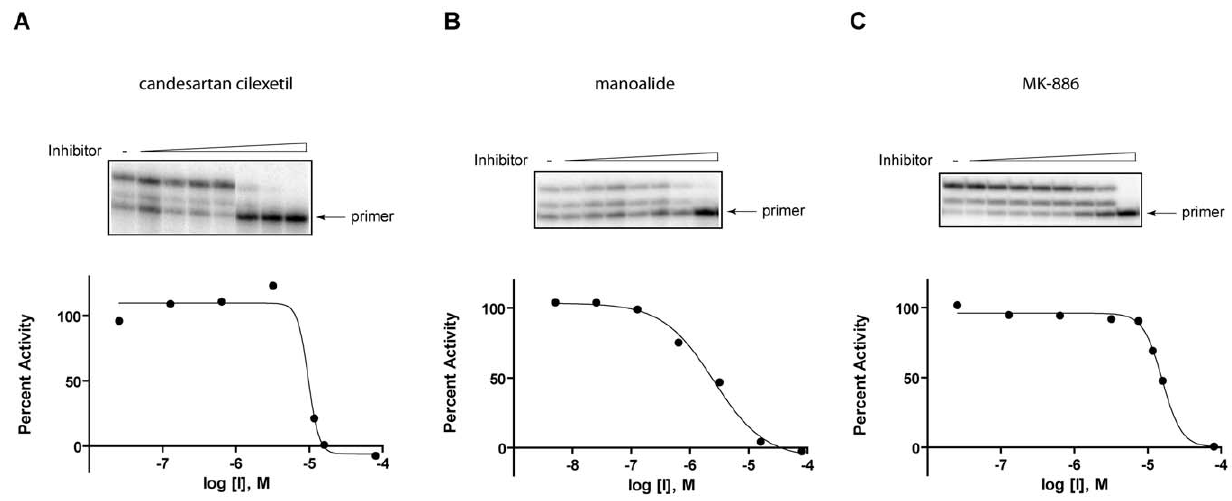
Figure 3. Dose-response activities of (A) candesartan cilexetil, (B) manoalide, and (C) MK-886 on non-damaged DNAs. Representative data from three independent experiments are shown. The gels shown on the top panel were used to generate dose-response curves shown on the bottom panel.